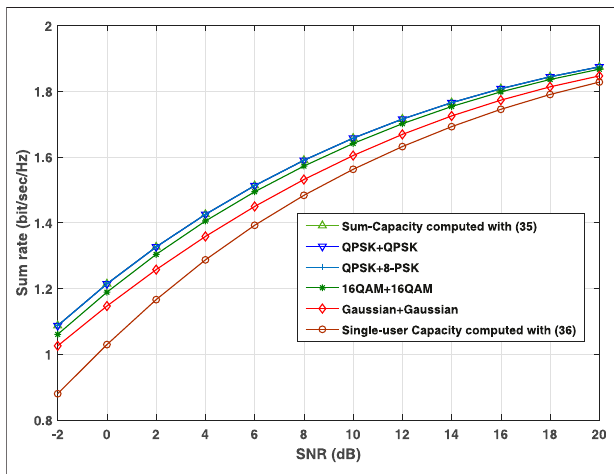
FIGURE 3 | Sum-rates achieved by different pairs of input signals and Single-usercapacityoverthe2-termGMMAC.Thetwousersareassumedto have equal transmit power P (cid:2) P 1 (cid:2) P 2 and single-user has transmit power P.